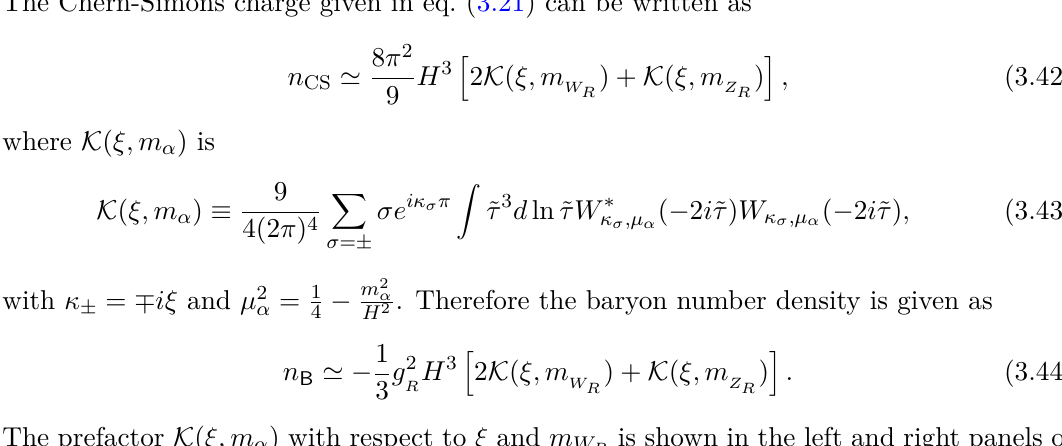
) vs ξ (left panel) and vs m WR